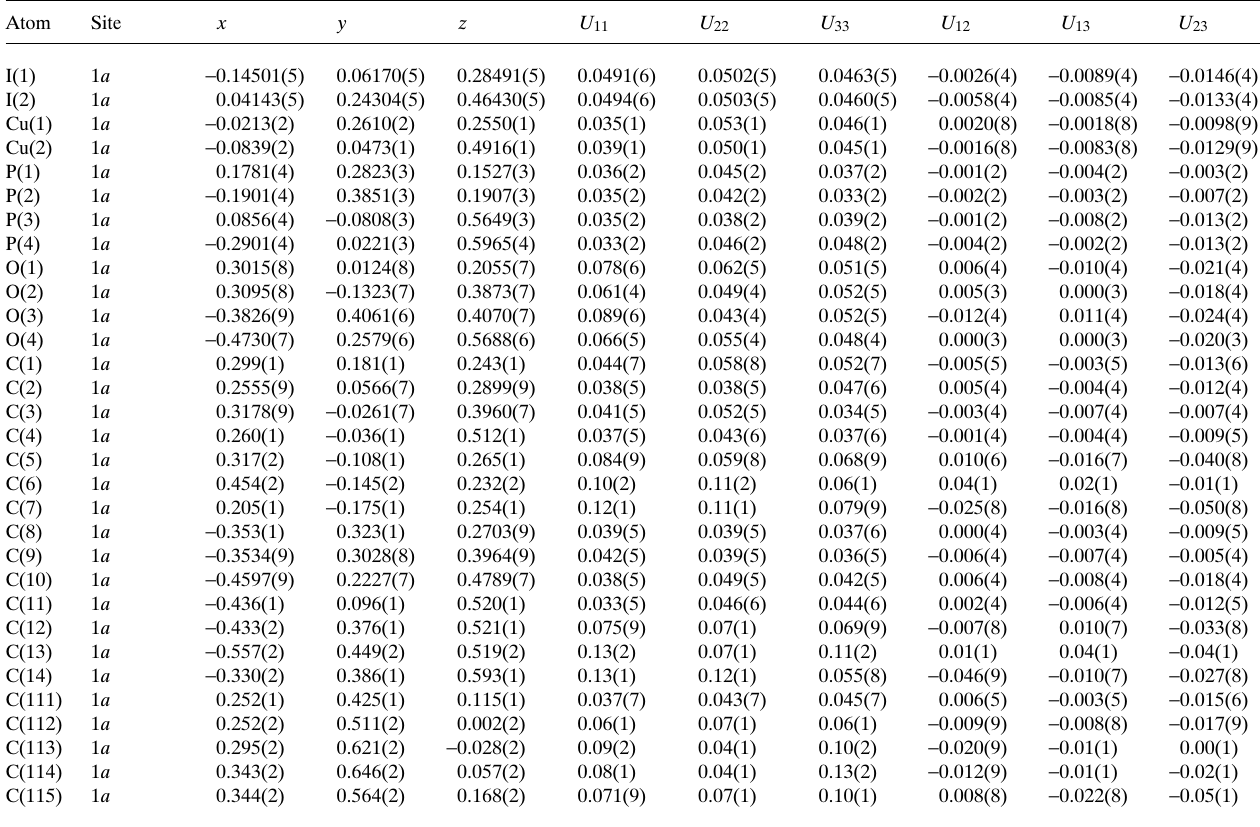
Table 3. Atomic coordinates and displacement parameters (in Å 2 ) .